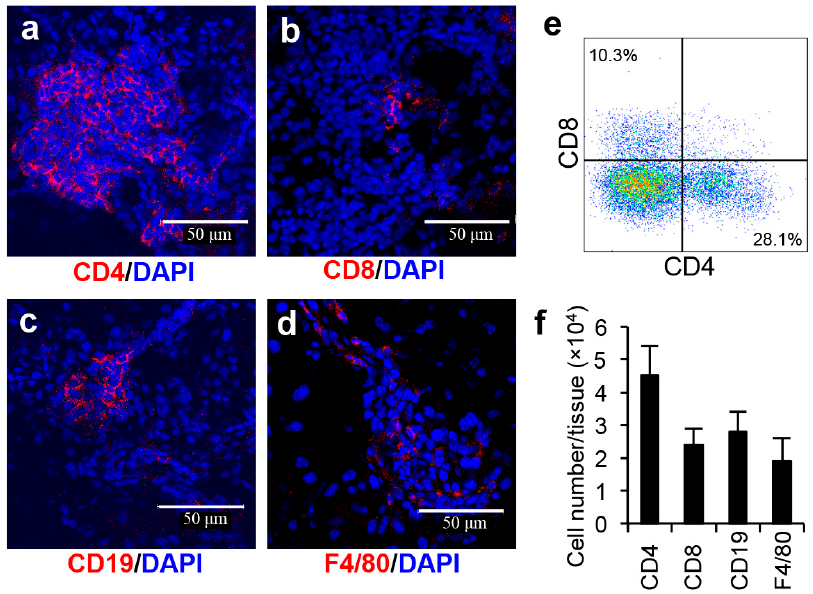
Figure 5. Immune cell infiltration of target organs of the SS model mice. CD4, CD8, CD19, and F4/80 expressing immune cells were observed by confocal microscopy. ( a ) CD4 + T cells, ( b ) CD8 + T cells, ( c ) CD19 + B cells, and ( d ) F4/80 + macrophages in the lacrimal glands of the SS model mice were detected by Alexa-546-conjugated antibodies. Nuclei were stained with 4 ′ ,6-diamdino-2-phenylindole dihydrochloride (DAPI). The results are representative of five mice. Scale bar: 50 μ m; ( e ) Flow cytometry analysis using lacrimal gland tissues from the SS model mice. CD4 and CD8 T cell subsets ware shown, and the result is representative of 5 mice; and ( f ) Cell numbers of CD4 + , CD8 + T cells, CD19 + B cells, and F4/8 + macrophages were calculated by flow cytometery analysis. Data are means ± SD of 5 mice.